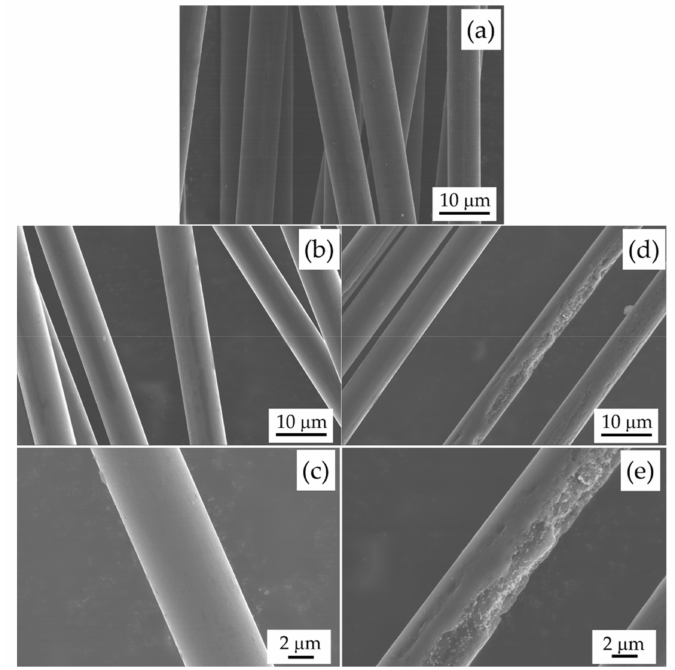
Figure 3. FE-SEM images of vCF ( a ); rCF-500 ( b , c ) and rCF-600 ( d , e